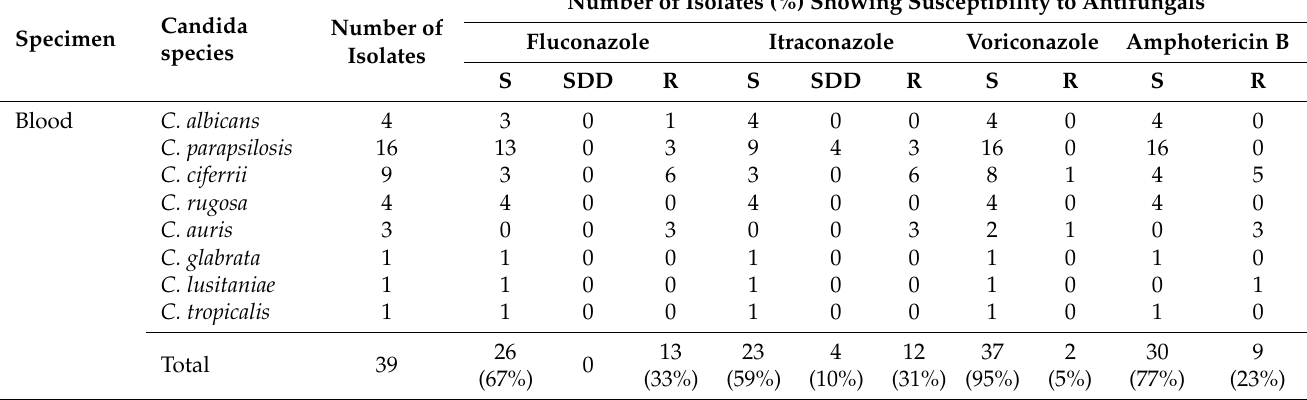
Antifungal susceptibility in each specimen (infection) type is shown in Table 3. The blood isolates exhibited 95% susceptibility to voriconazole, while showing lower suscepti- bility to fluconazole and itraconazole (67–69%). In contrast, isolates from HVSs and aural swabs were more susceptible to fluconazole as well as nystatin (78–94%), with lower sus- ceptibility to clotrimazole. The distribution of the MICs of amphotericin B (blood isolates) is indicated in Table S3. Table 3. Susceptibility to antifungals among Candida isolates from different specimens.